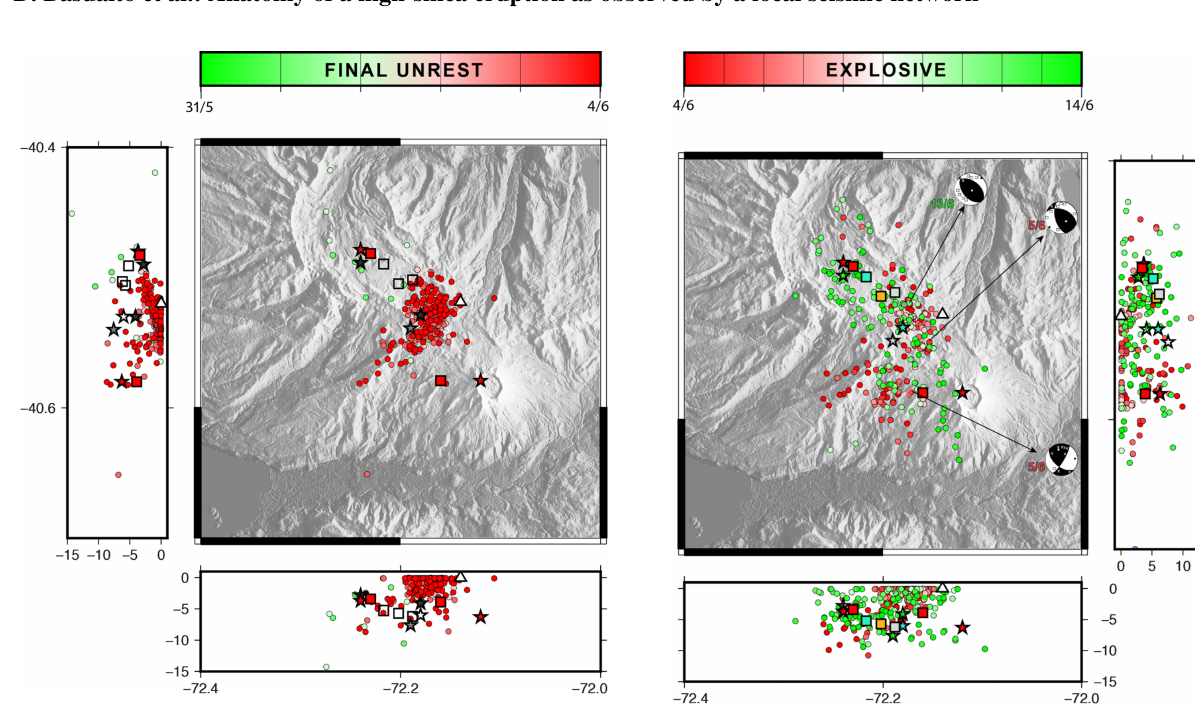
Figure 7. Relocations of seismicity recorded after eruption onset during the explosive phase. See the caption of Fig. 5 for an expla- nation of symbols and colors. In this case, focal mechanisms (white and black circles) were calculated by first arrivals, with squares and crosses representing negative and positive